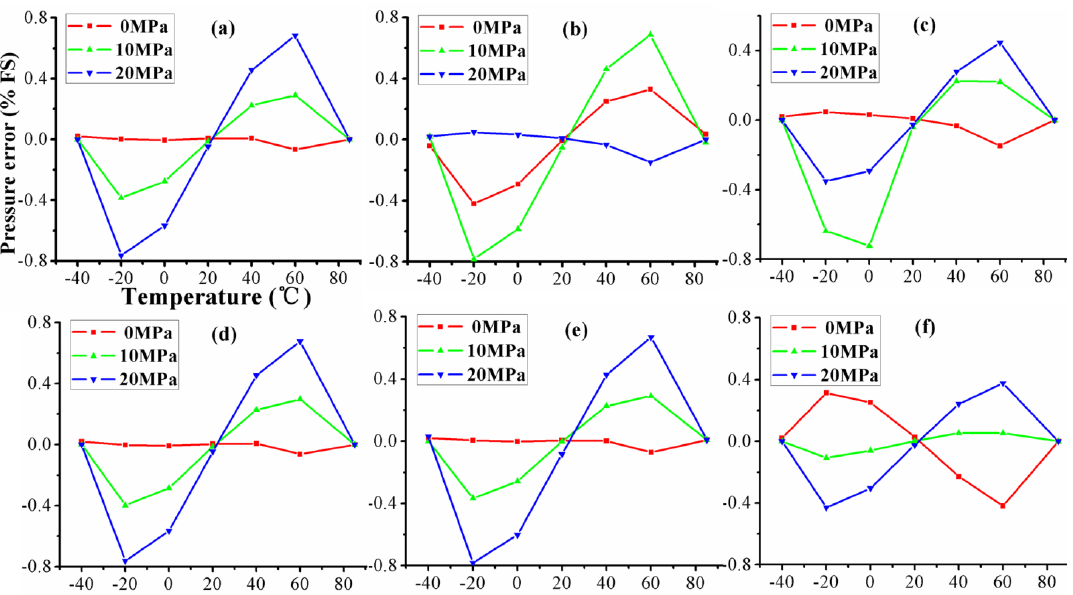
Figure 9. The compensated errors of algorithms at three pressure points on temperature